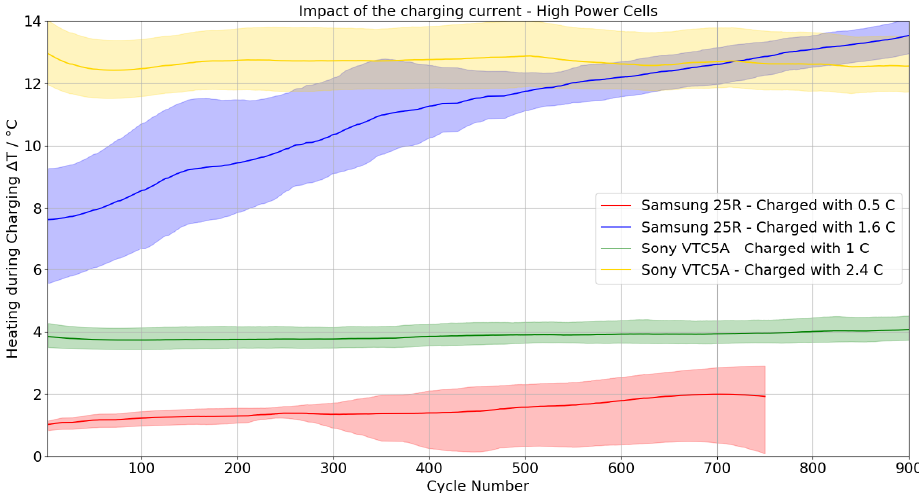
Figure 7. Development of the maximum temperature rise during the charging process of the cycle test of the high-power cells. Solid lines represent the mean values, shaded areas represent the spread of the measured values.